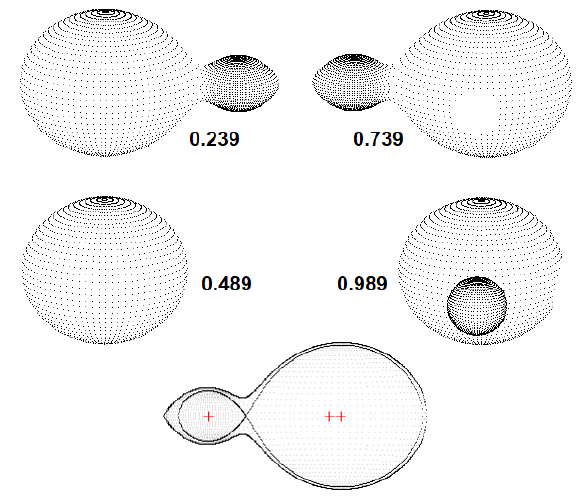
Fig. 5. The geometrical structure of V870 Ara at the four phases, and the cross-sectional outline of the binary system at the phase of 0.739 with contact degree f =